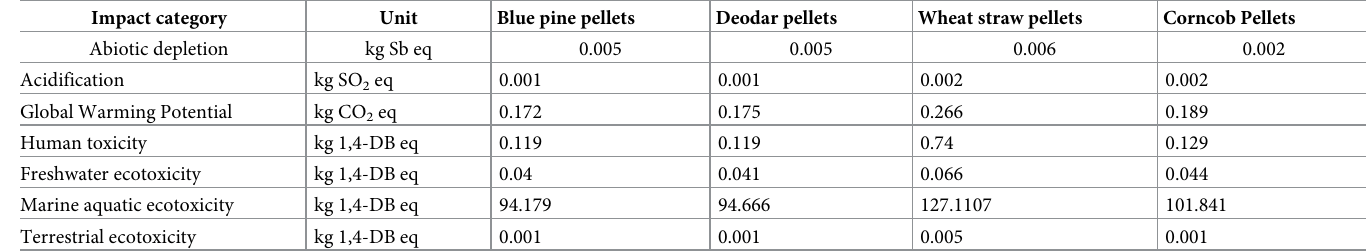
Table 3. Environmental impacts posed by biomass pellets production from selected agro-forest species sawdust/residues.